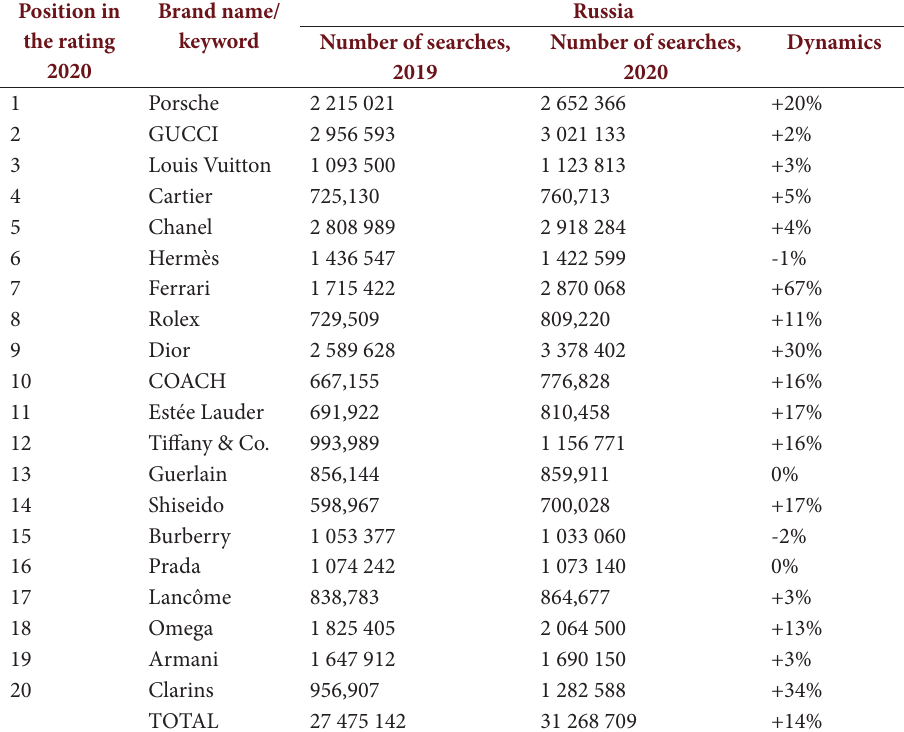
Table 2. Dynamics of search TOP-20 luxury and premium brands in Russia Position in the